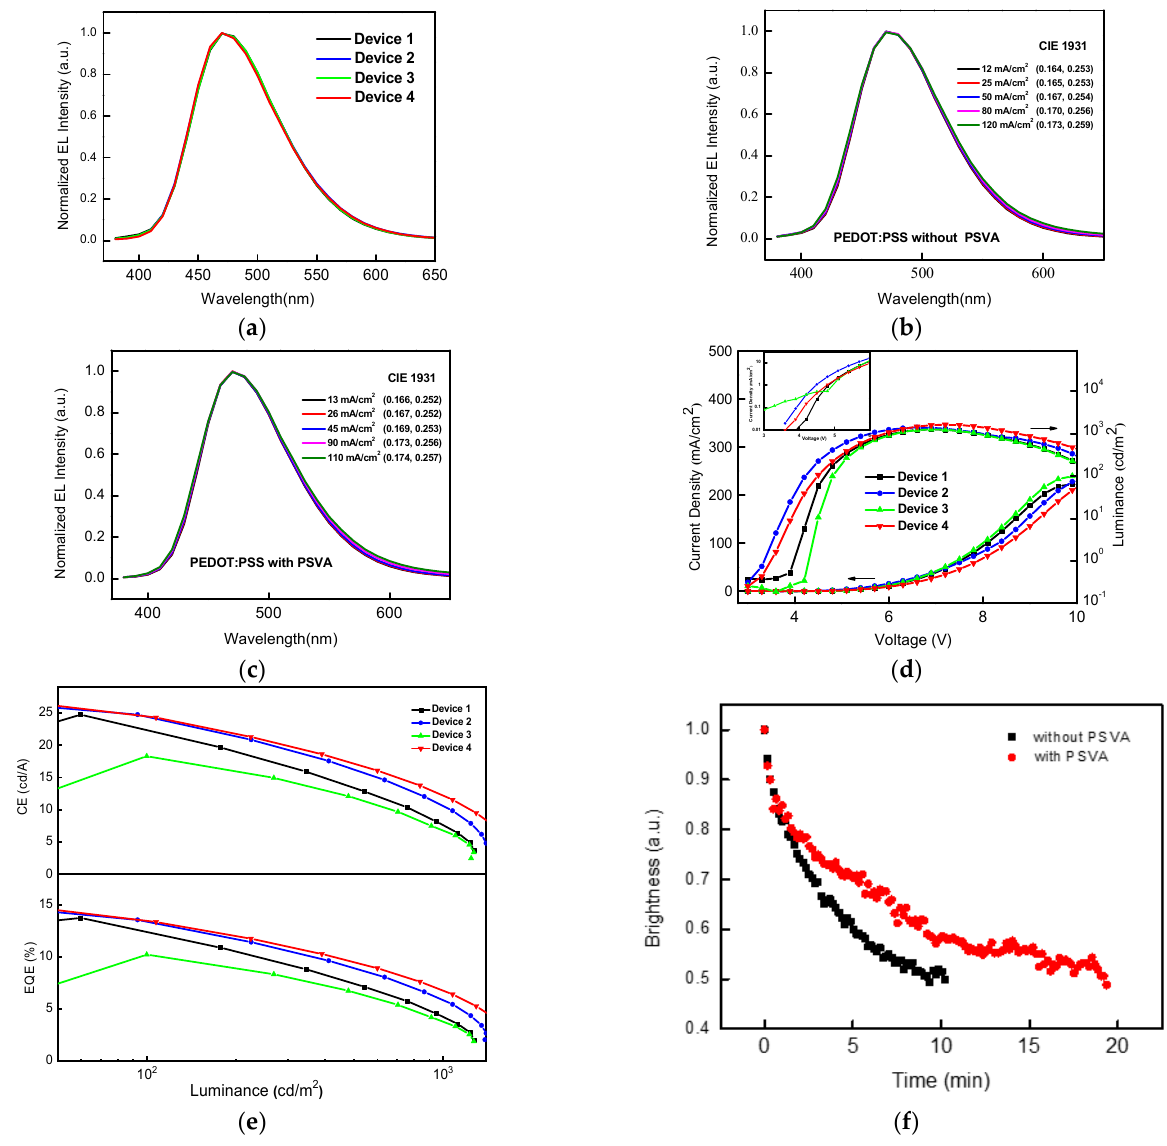
Figure 2. ( a ) The normalized EL spectra of devices at the same brightness, EL spectra and CIE coordinates of device 1 ( b ) and device 4 ( c ) with the variation of applied current densities, ( d ) J-V-L characteristics (the illustration in the figure shows I-V curve of logarithmic coordinates of low voltage), ( e ) CE-L, EQE-L curve of the as-fabricated blue TADF OLEDs and ( f ) lifetime (at the initial luminance of 500 cd/m 2 ) of devices with or without PSVA.